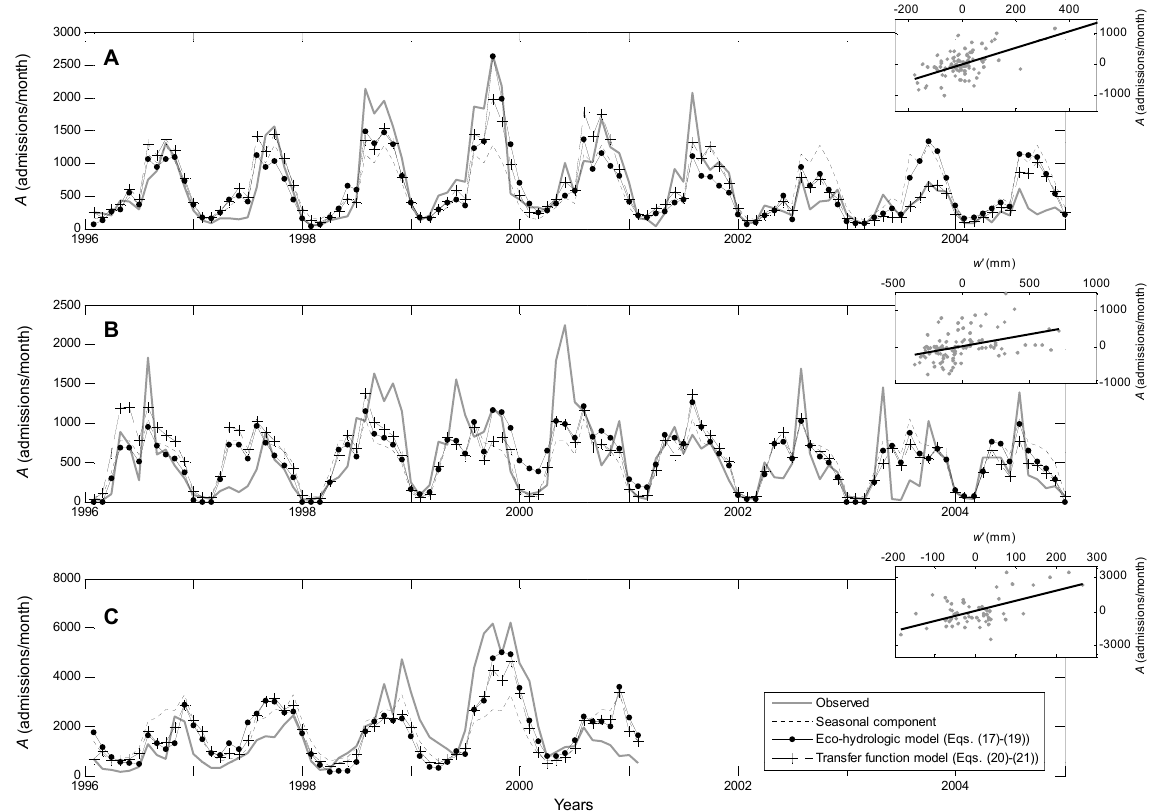
Fig. 4. Observed and modeled monthly malaria incidence for (A) Mpumalanga, (B) Limpopo and (C) KwaZulu-Natal provinces. Observed incidence is shown alongside seasonal averages, case estimates from the ecohydrological model, and case estimates from the transfer function model. Insets are scatter plots of soil water content anomalies against malaria case anomalies for each province (dots, observations; solid lines, modeled relationships using Eqs. (17) and (19)). Best fit parameters are reported in Table